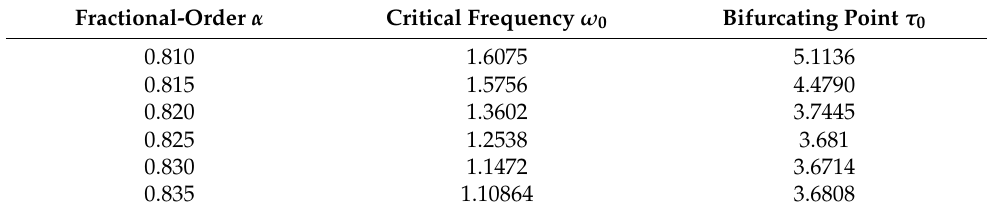
Figure 8. Fitting the recovered cases of model (2) for COVID-19 versus real observations of recovered cases in the UAE. ( a ) Model fitting without the vaccinated population. ( b ) Model fitting with the vaccinated (after 50%) population. ( c ) Model fitting with the vaccinated (after 100%) population. ( d ) Time-delayed model fitting without the vaccinated population. ( e ) Time-delayed model fitting with the vaccinated (after 50%) population. ( f ) Time-delayed model fitting with the vaccinated (after 100%) population. Table 3. Fractional-order α and bifurcating point τ 0 .